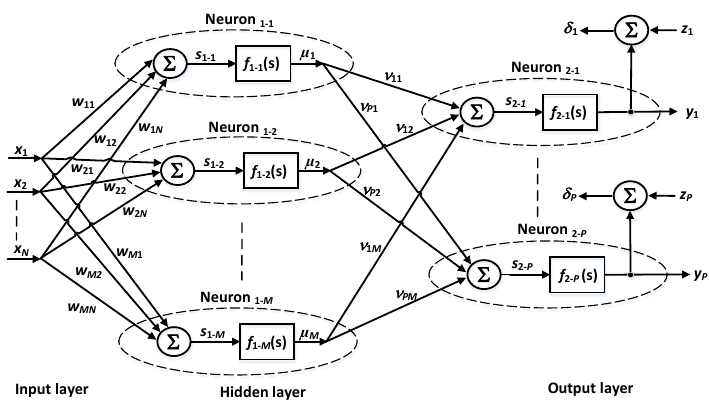
Figure 1. Block diagram of the backpropagation artificial neural network (BP ANN) (with a single hidden layer).